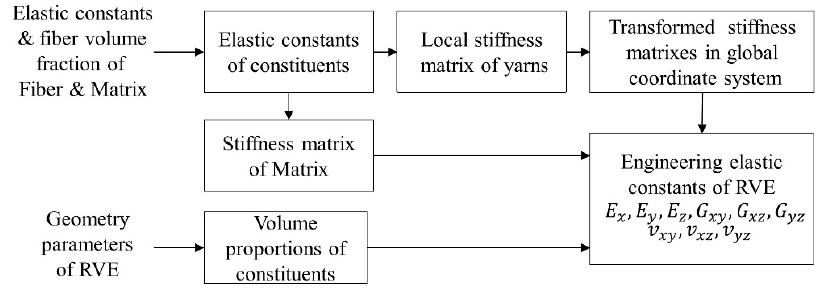
Table 5. Volume proportion of impregnated yarns.